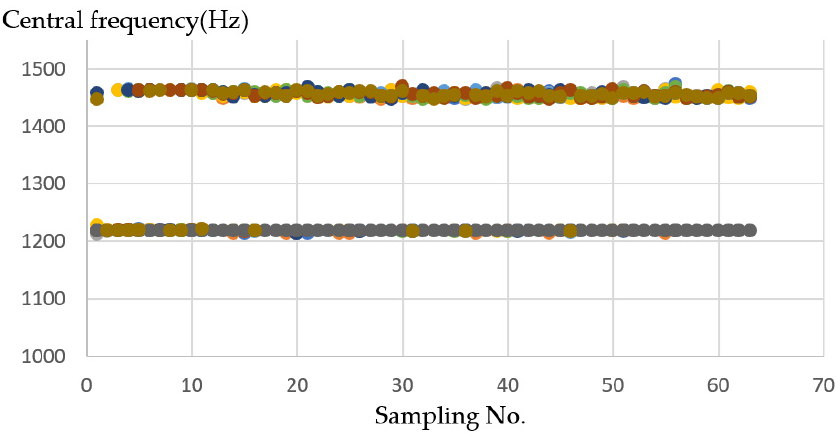
Figure 14. Ten sample frequency results from clustering by K-means for the XYZ axes.